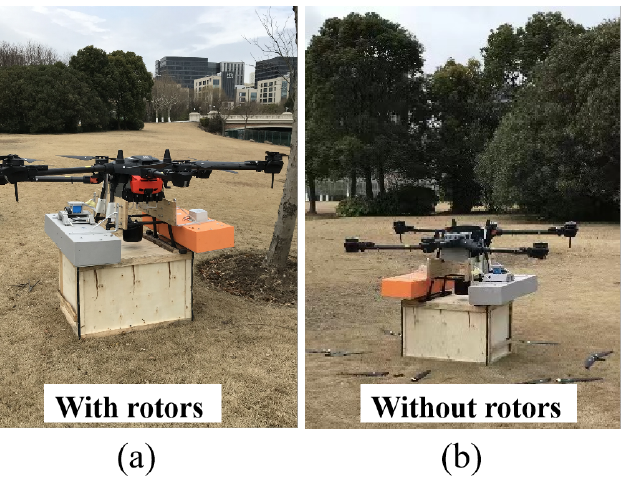
Figure 11. The scene of rotor interference test in the case of ( a ) UAV-GPR with rotors and ( b ) UAV-GPR without rotors.